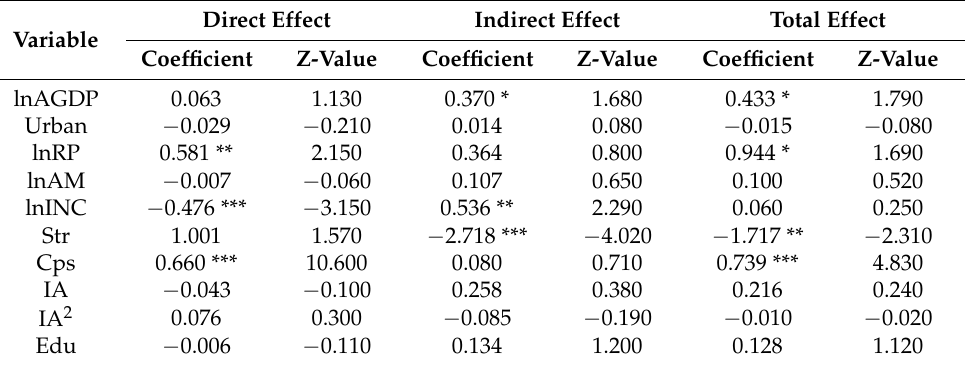
Table 12. Estimation of the direct and indirect effects of various factors on the ACESs by region (non-mountainous